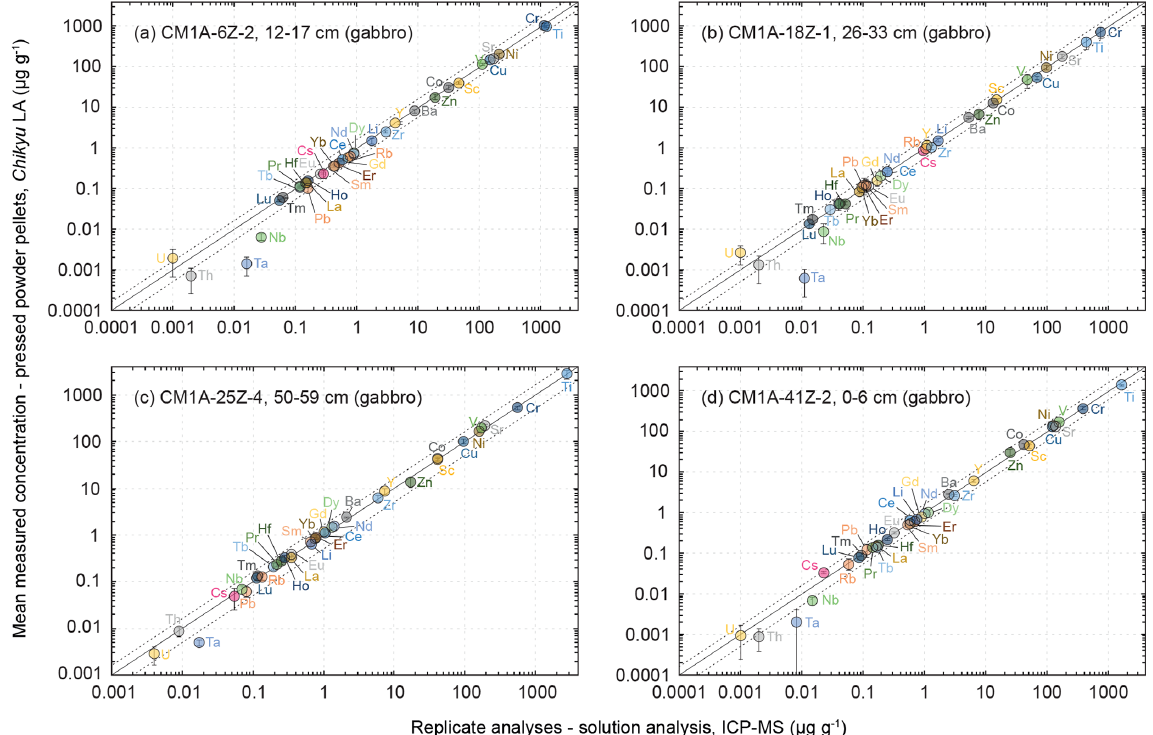
Figure 6. Comparison of the mean measured concentrations obtained by LA-ICP-MS on pressed powder pellets with the analysed replicates for the same samples (solution analysis, University of Southampton, UK) for four gabbro samples from Hole CM1A. The selected samples are (a) CM1A-6Z-2, 12–17cm ( n = 5), (b) CM1A-18Z-1, 26–33cm ( n = 5), (c) CM1A-25Z-4, 50–59cm ( n = 6), and (d) CM1A-41Z-2, 0–6cm ( n = 6). The black solid line is the 1:1 line between the concentrations determined by LA-ICP-MS on-board the D/V Chikyu and for the replicates. The black dashed lines represent 50% deviation from the 1:1